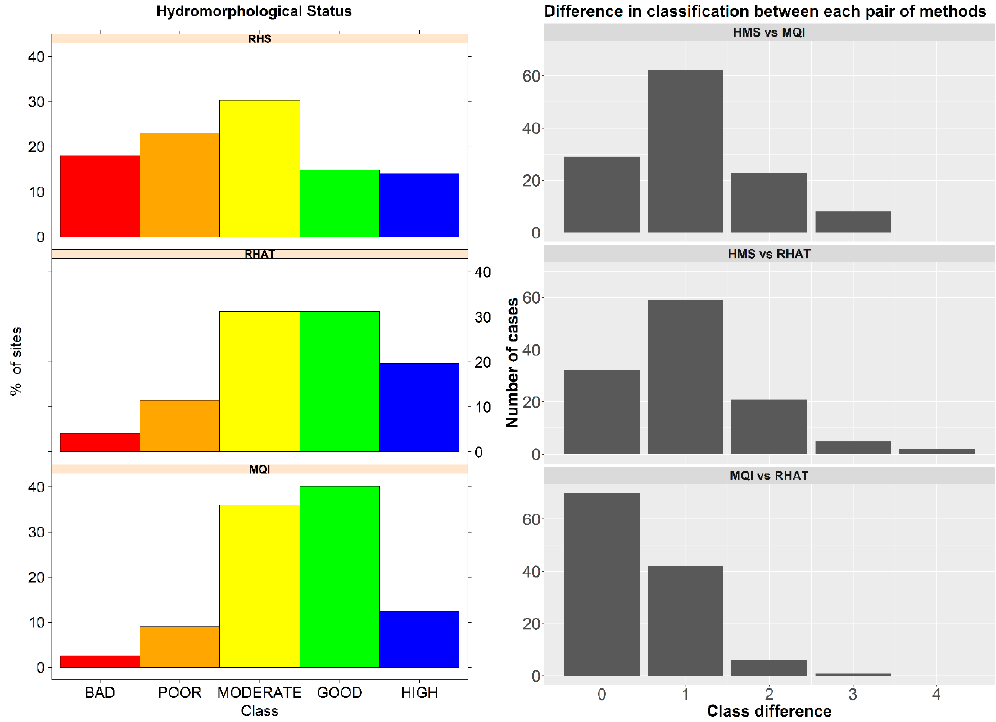
Figure 3. Distribution of hydromorphological quality class defined by each assessment method ( left ) and distribution of class difference between methods ( right ).